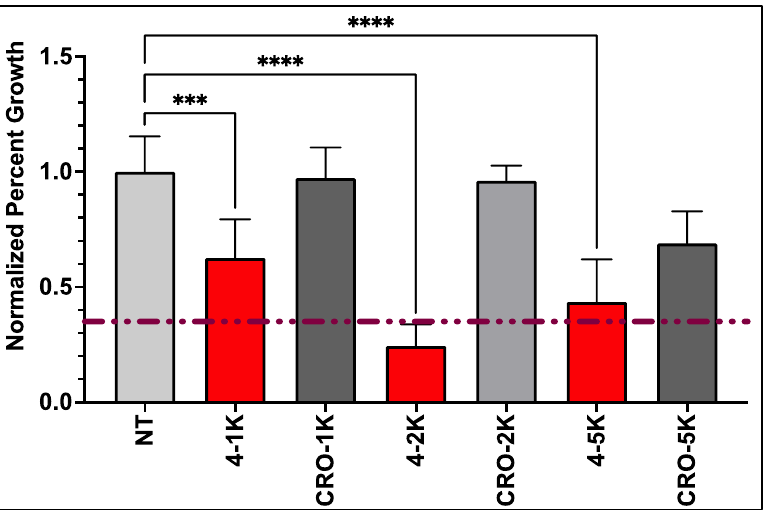
Figure 8. Proliferative effects at differing oligo concentrations on U87MGs from optimal 9X co- conjugated 4 nm GNPs conjugated with either PEG/AS1411 or PEG/CRO. Statistical significance of *** represents p < 0.0002 and **** represents p < 0.0001. No treatment (NT) and 10 µ M AS1411 treatments serve as controls. Percent growth measurements normalized to initial seeding density (dashed red